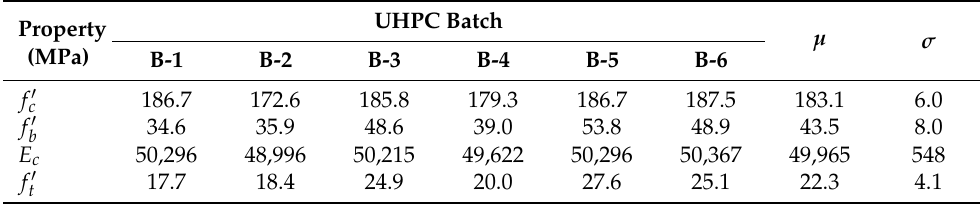
Table 5. Mechanical characteristics of